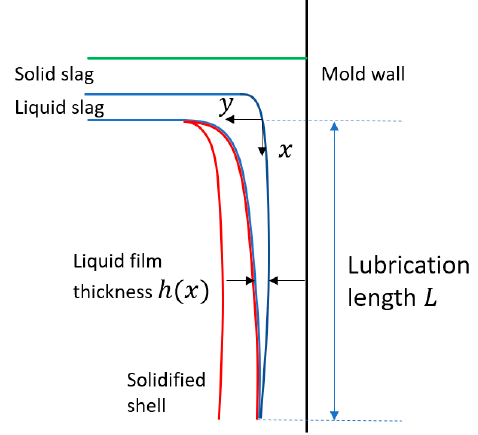
Figure 5. Schematic of simulation domain.